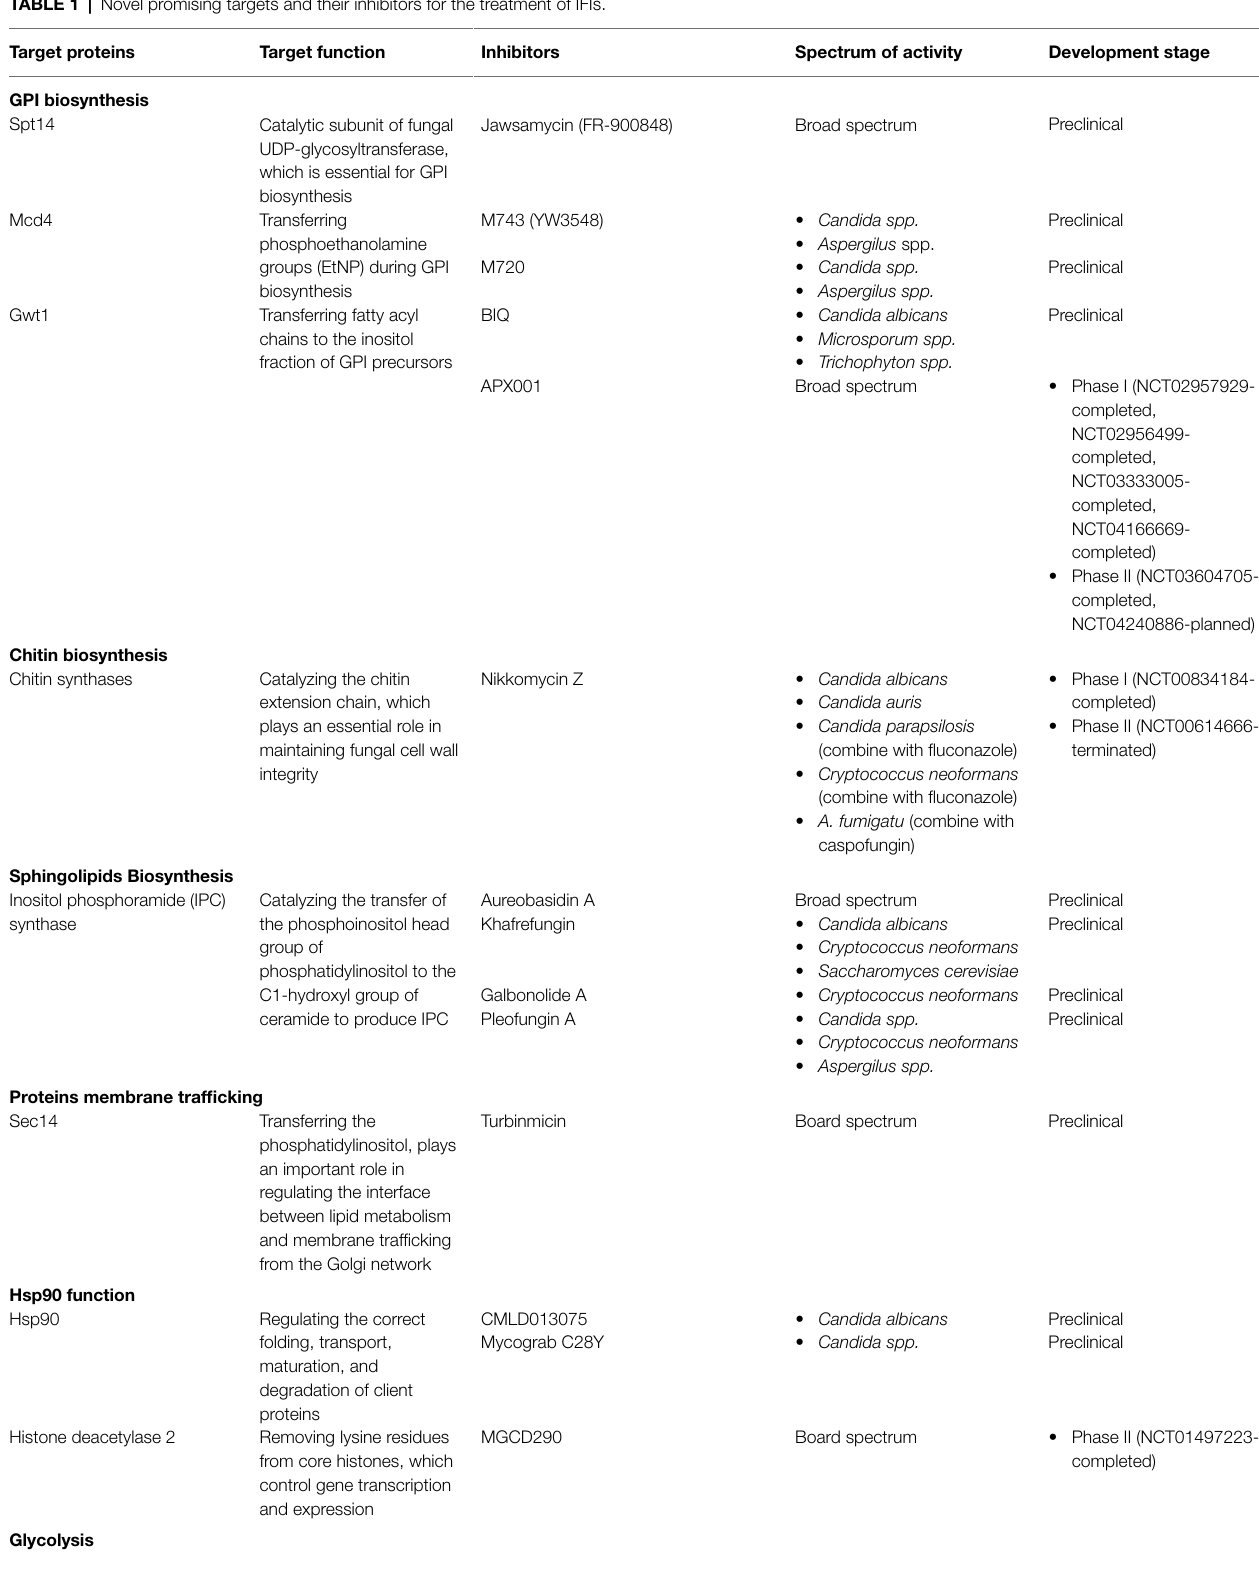
TABLE 1 | Novel promising targets and their inhibitors for the treatment of